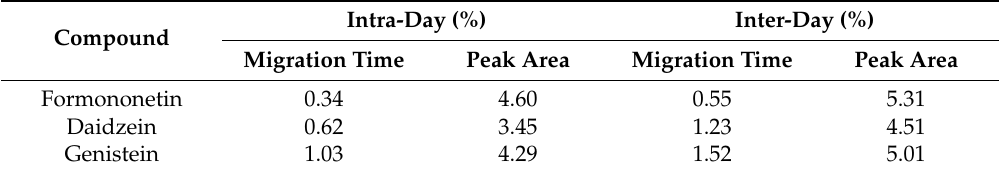
Table 1. Intra-day and inter-day precision of migration time and peak area for isoflavones.